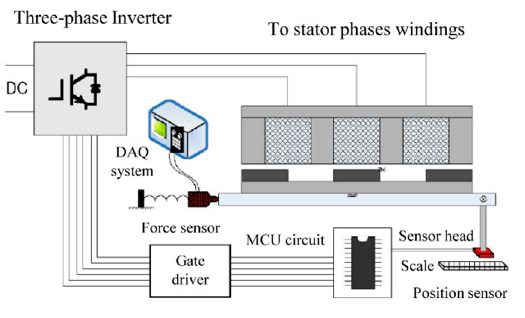
Figure 16. Feedback control scheme for starting the free piston engine [43].